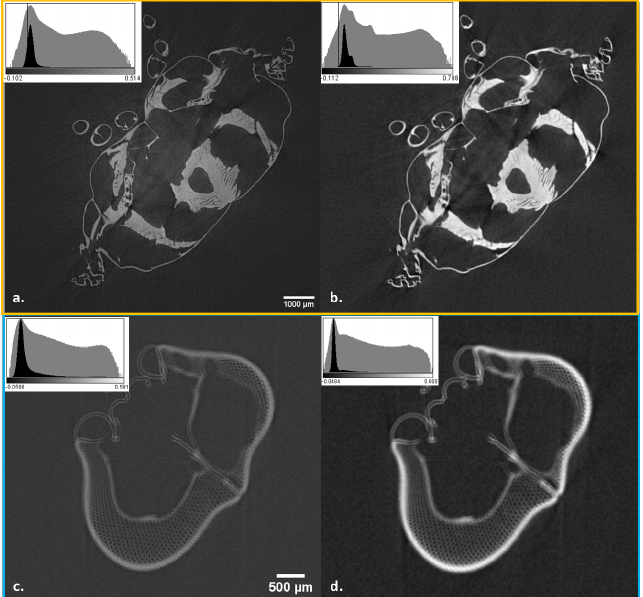
Figure 1. Micro-CT slices of a horse fly based on attenuation ( a , c ), and based on Paganin phase retrieval ( b , d ). The upper images are showing a horizontal slice at the region of the flight muscles (orange framed in Figure 4a,b), whereas the lower images are taken at the level of the compound eye showing clearly the individual ommatidia (blue framed in Figure 4c,d). The insets show the gray value histograms for the different images (black-linear scale, gray-log scale is shown to be able to better discern the differences). It is clear from those that the Paganin method strongly increases the CNR of the images as the histograms are becoming much more structured, showing several peaks compared to the attenuation case. A ν value of 10.0 was used in Equation (6) to obtain the images. The CNR values for the different methods and samples are summarized in Table